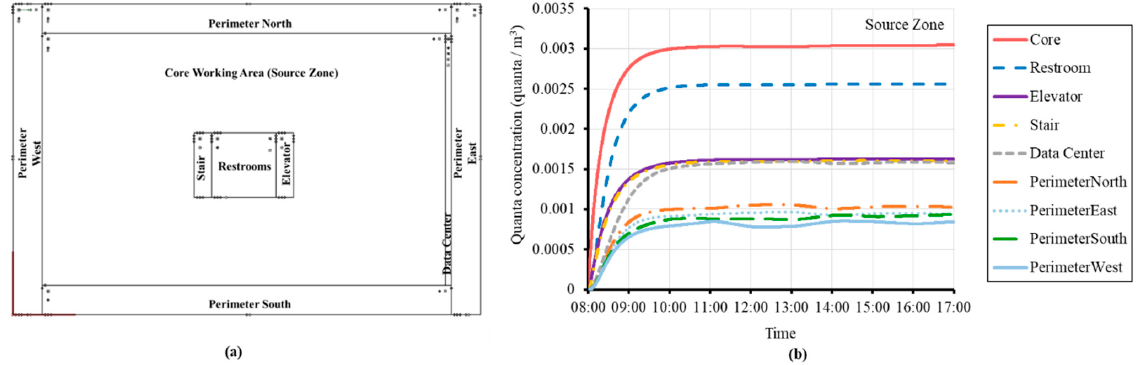
Figure 5. Medium Office ( a ) top-view diagram showing outdoor air flows (blue) and exhaust/return flows (gray) and ( b ) quanta concentration as a function of time during a workday with the infector in the core zone on the first floor. Contaminant generation source and deposition/deactivation items were added on the top-left of each room (small symbols).